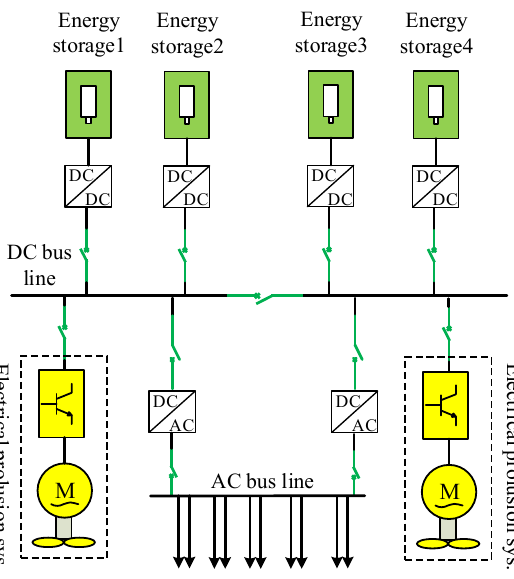
Figure 1. Generic diagram of a battery-only power IPS.